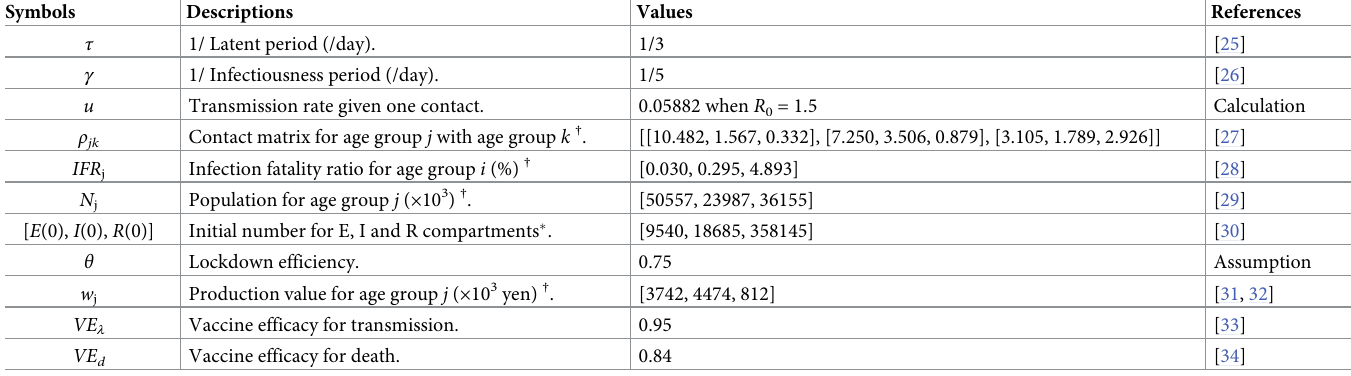
Table 1. Summary of parameters used in the